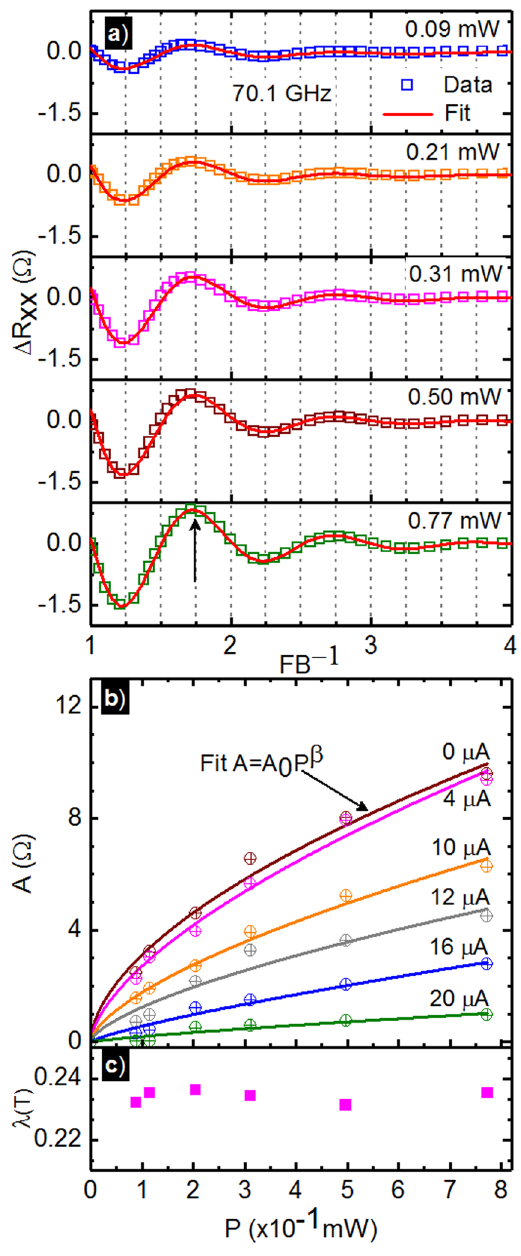
Figure 3. ( a ) This figure exhibits the oscillatory Δ R xx extracted by subtracting the non-oscillatory magnetoresistance from the experimental data at different microwave power. The plot shows Δ R xx vs. FB − 1 at various P for I dc = 0 μ A . Here, F is the magnetoresistance oscillation frequency and B is the magnetic field. The symbols represent data while the lines represent fits to exponentially damped sinusoids, see text. ( b ) The magnetoresistance oscillation amplitude, A , vs. P is shown for different I dc from 0 μ A to 20 μ A (circles). Also shown are the power-law fits, A = A 0 P β (solid lines). Fit extracted A 0 and β are shown in Table 2. (c) The damping constant, λ , in the exponentially damped sinusoidal fit of the oscillatory magnetoresistance is plotted vs. P